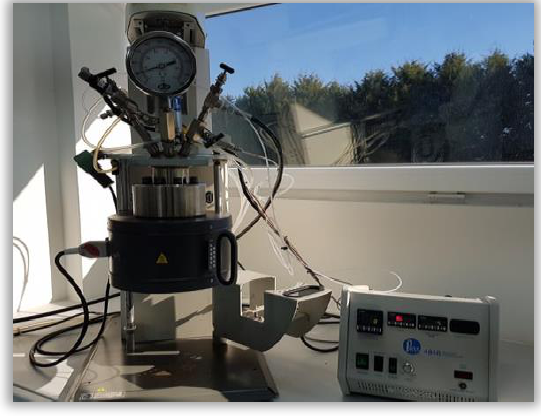
Figure 1. Subcritical water extractor used.